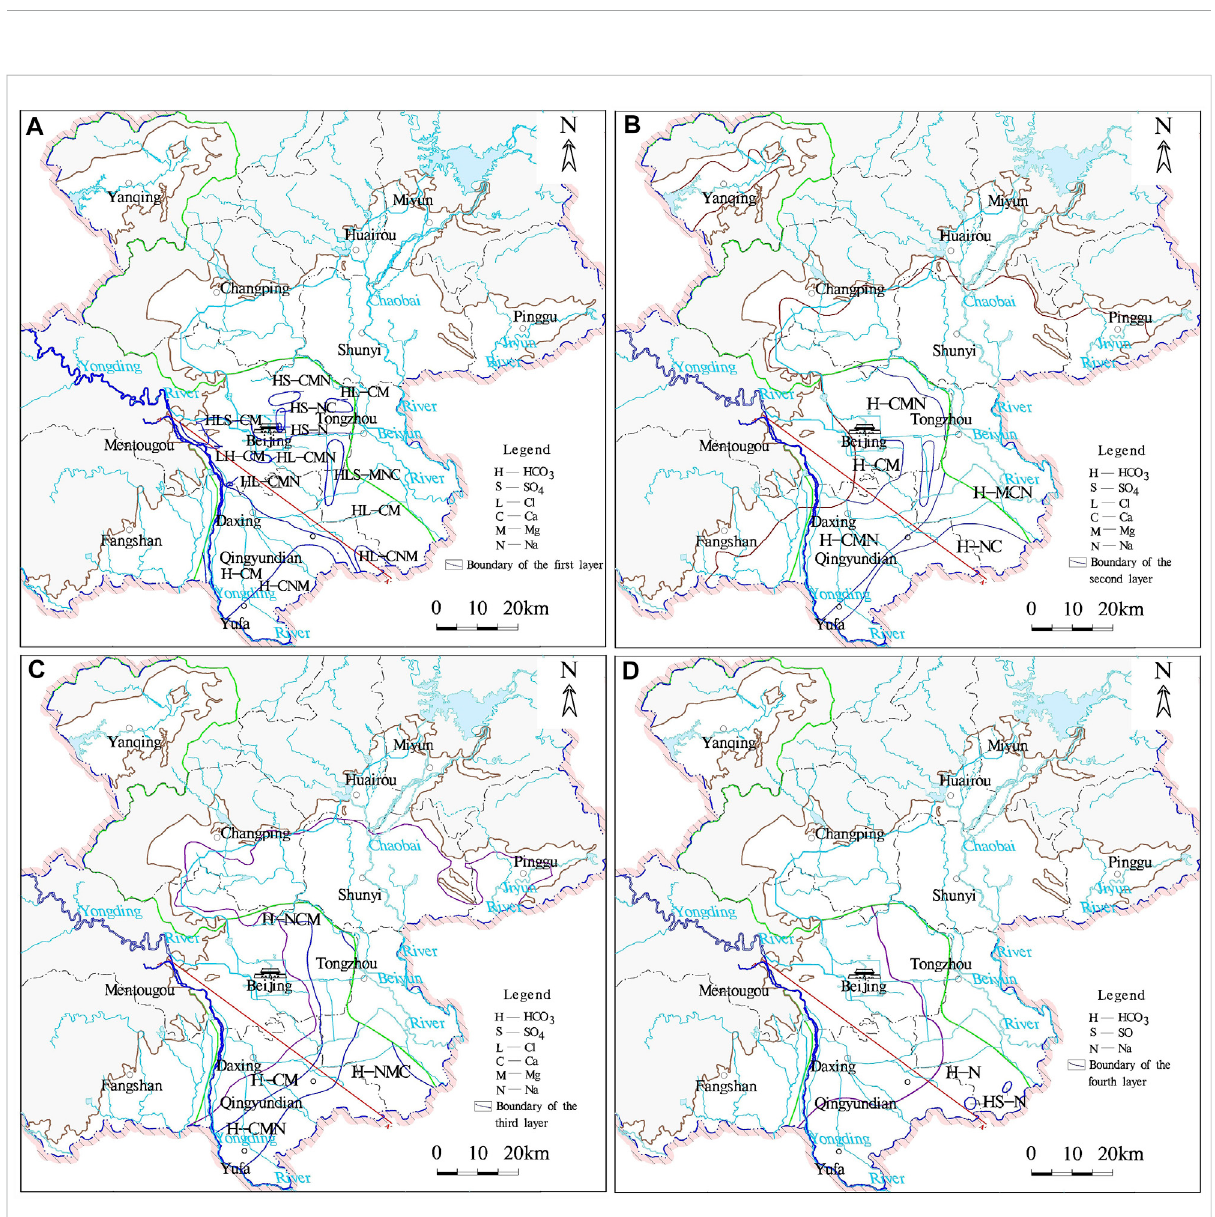
FIGURE 10 Distribution of hydrochemical types in the plain area in Beijing. (A) First aquifer, (B) second aquifer, (C) third aquifer, and (D) fourth aquifer.